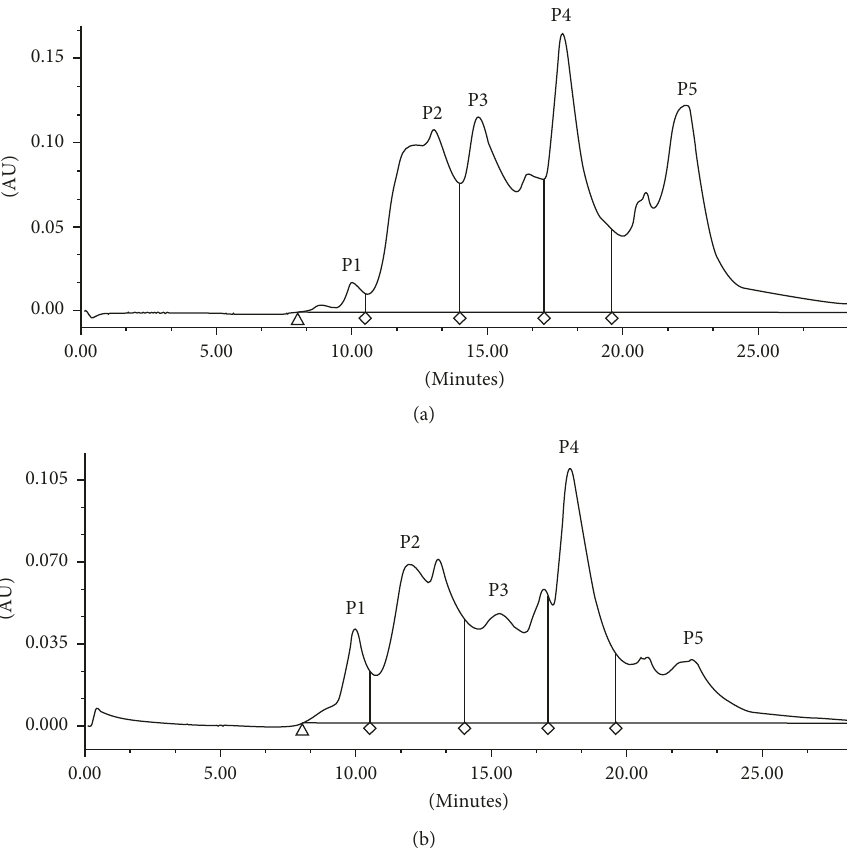
Figure 1: The SE-HPLC profile of the protein content in Mpembuke grain: first extraction (a) and second extraction (b). P1–P5 shows the different peaks referred to in Table 6 and in the